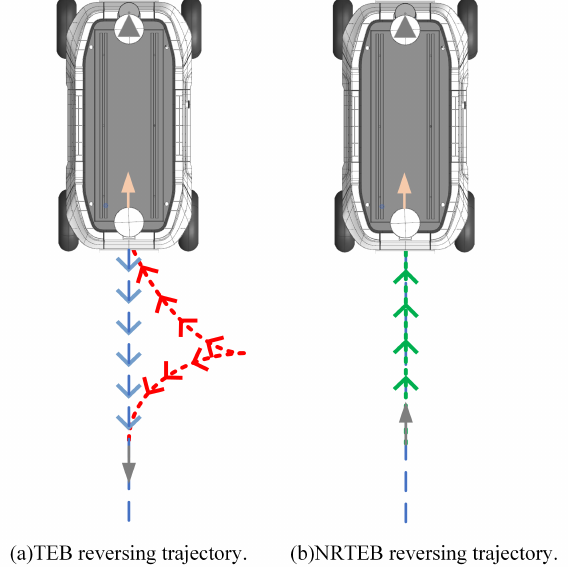
Figure 4. Reverse trajectory comparison. The blue dashed line indicates the global path. The red dashed line is the parking trajectory of the TEB. The green dashed line is the direct reversing trajectory of NRTEB. The arrow indicates the heading of the path